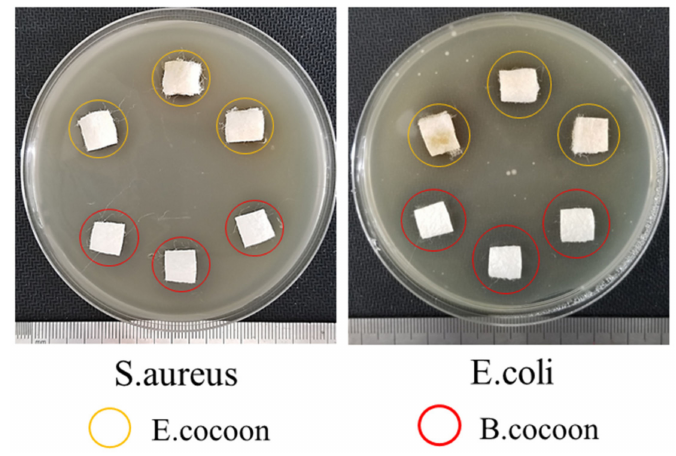
Figure 14. Antimicrobial activities of E and B